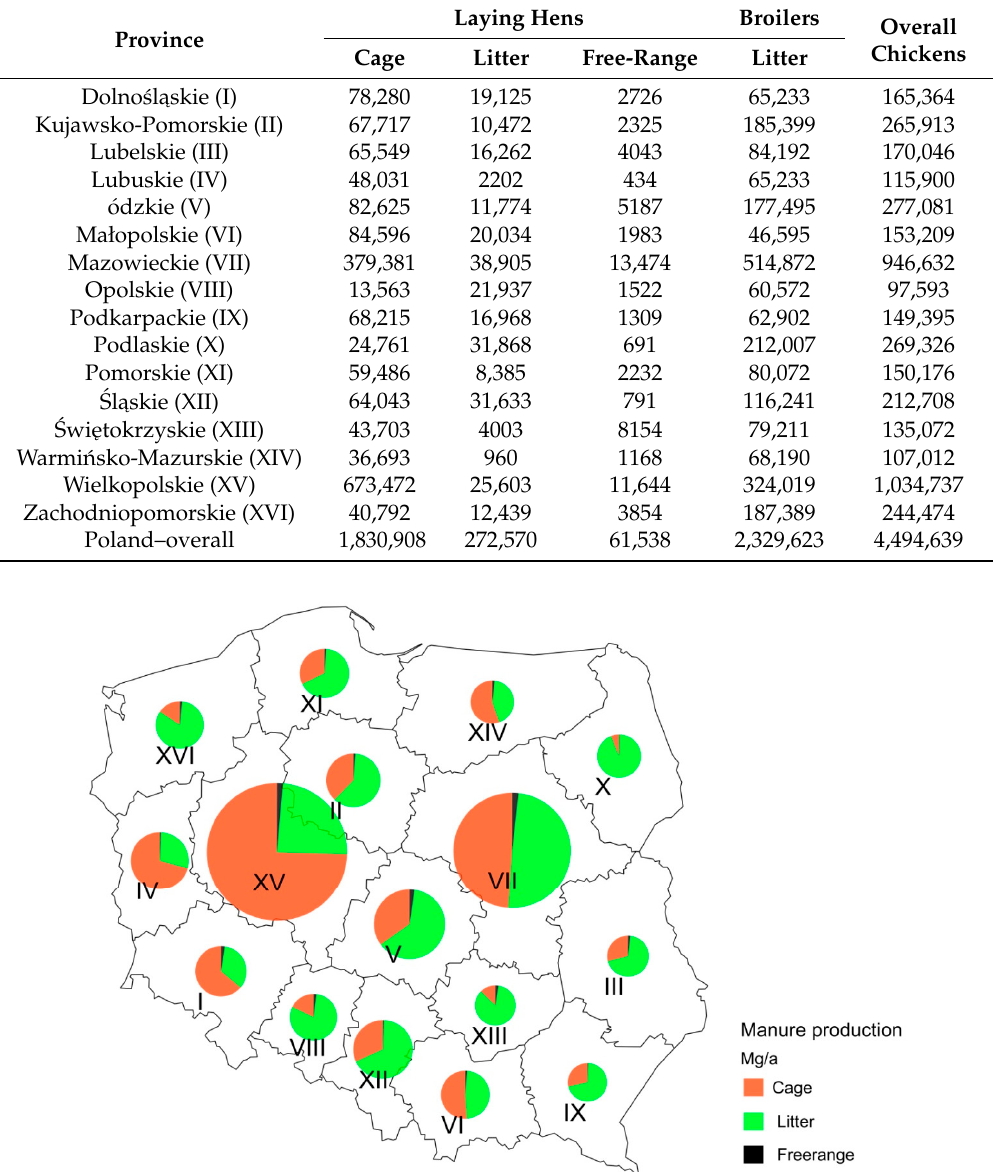
Figure 4. Annual chicken manure potential from various rearing systems in provinces of Poland.